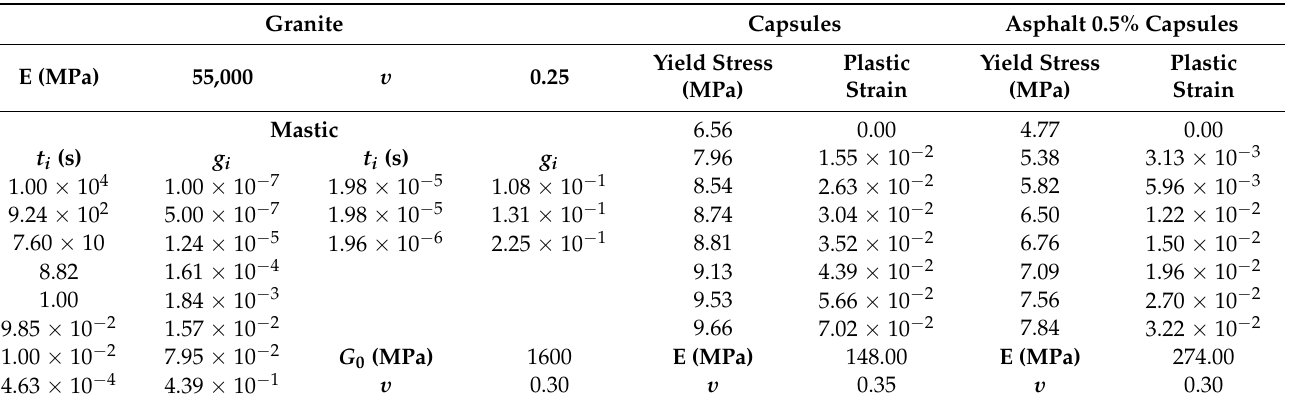
Table 4. Properties for the FE model.